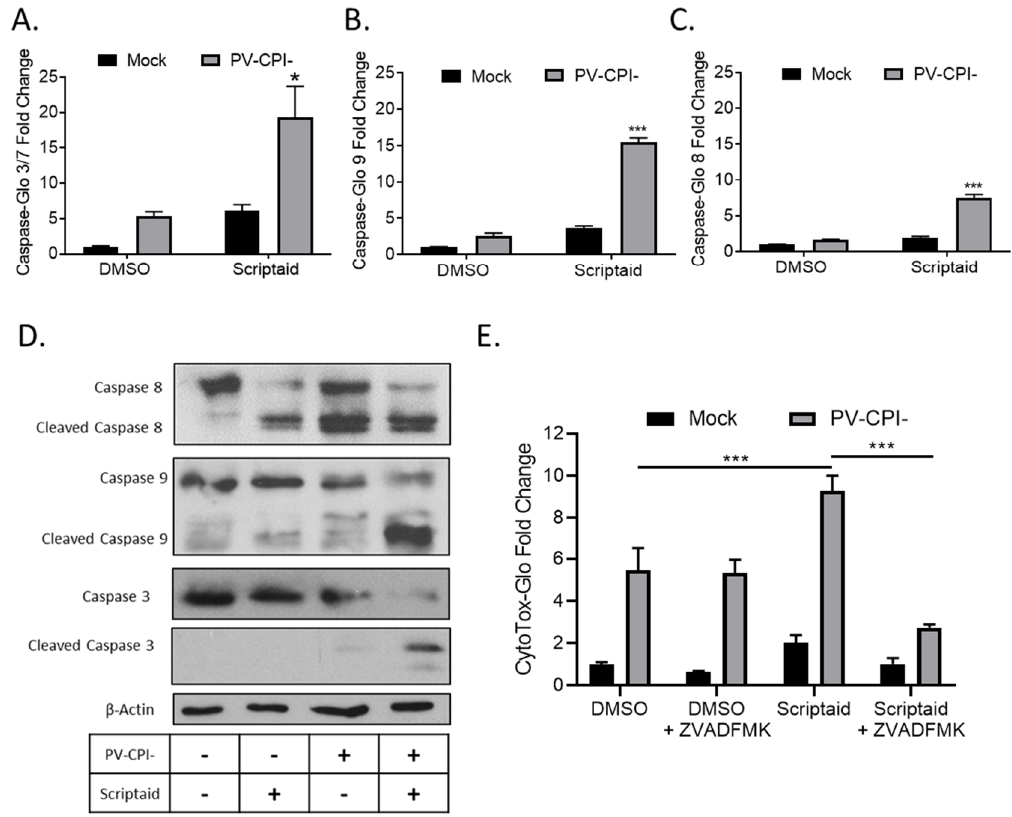
/ V-CPI- infected cells. ( A – C ) H1299